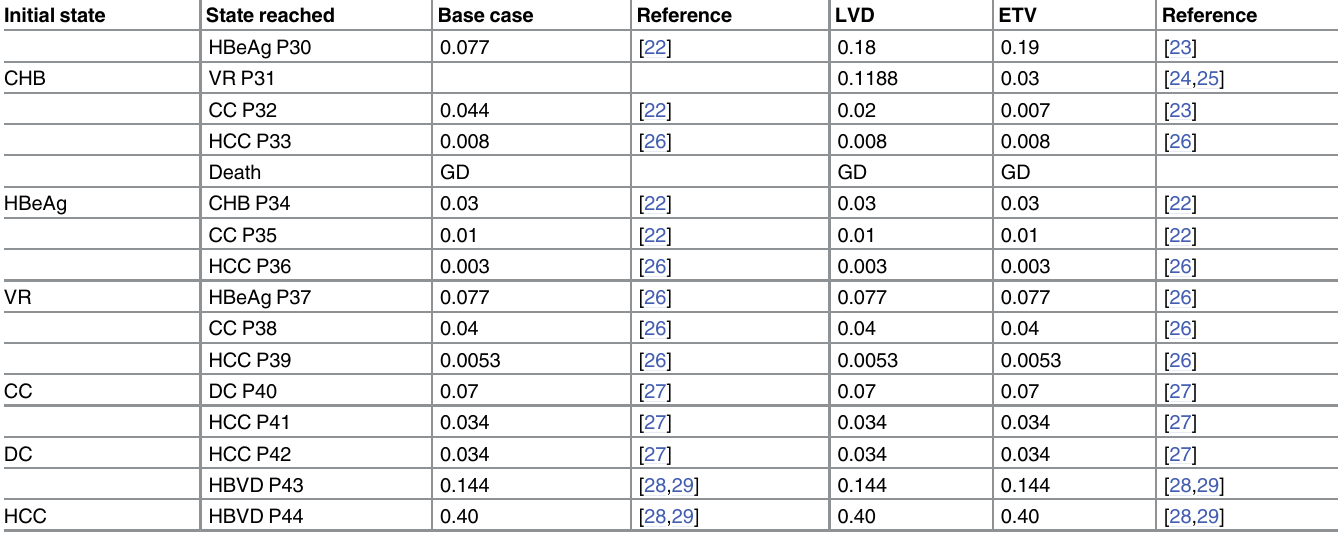
Table 2. Probability of reaching each state of chronic hepatitis B.